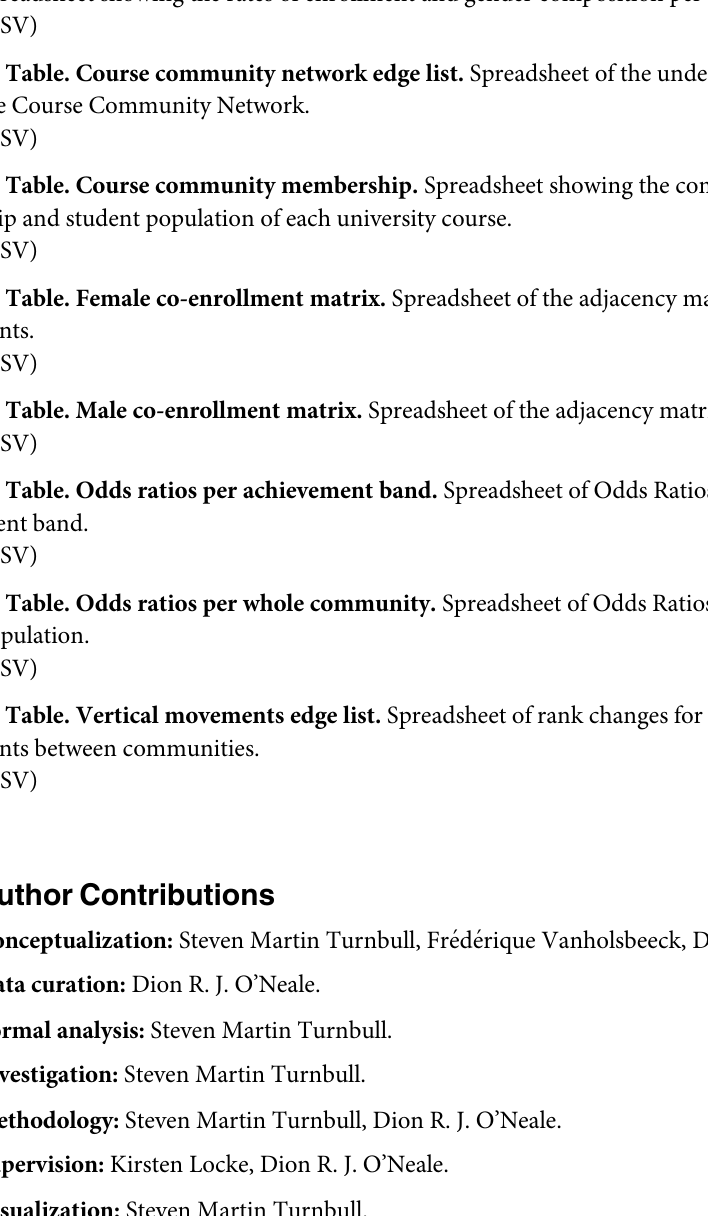
S1 Table. Compositions of the communities detected in the co-enrollment network. Spreadsheet showing the rates of enrollment and gender composition per community. S2 Table. Course community network edge list. Spreadsheet of the underlying edge list for the Course Community Network. S3 Table. Course community membership. Spreadsheet showing the community member- ship and student population of each university course. S4 Table. Female co-enrollment matrix. Spreadsheet of the adjacency matrix for female stu- dents. S5 Table. Male co-enrollment matrix. Spreadsheet of the adjacency matrix for male students. S6 Table. Odds ratios per achievement band. Spreadsheet of Odds Ratios split by achieve- ment band. S7 Table. Odds ratios per whole community. Spreadsheet of Odds Ratios for whole student population. S8 Table. Vertical movements edge list. Spreadsheet of rank changes for male and female stu- dents between